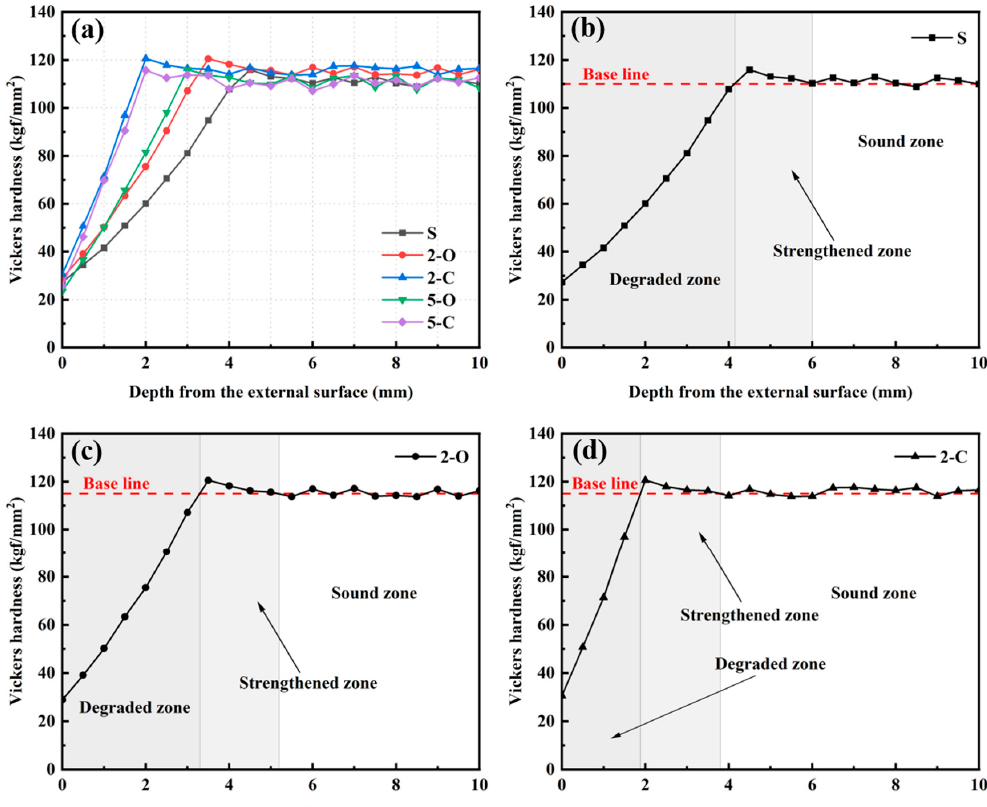
Figure 9. Vickers hardness of specimens under sulfate attack (a: all specimens; b: the S specimen; c: the 2-O specimen; d: the 2-C specimen).